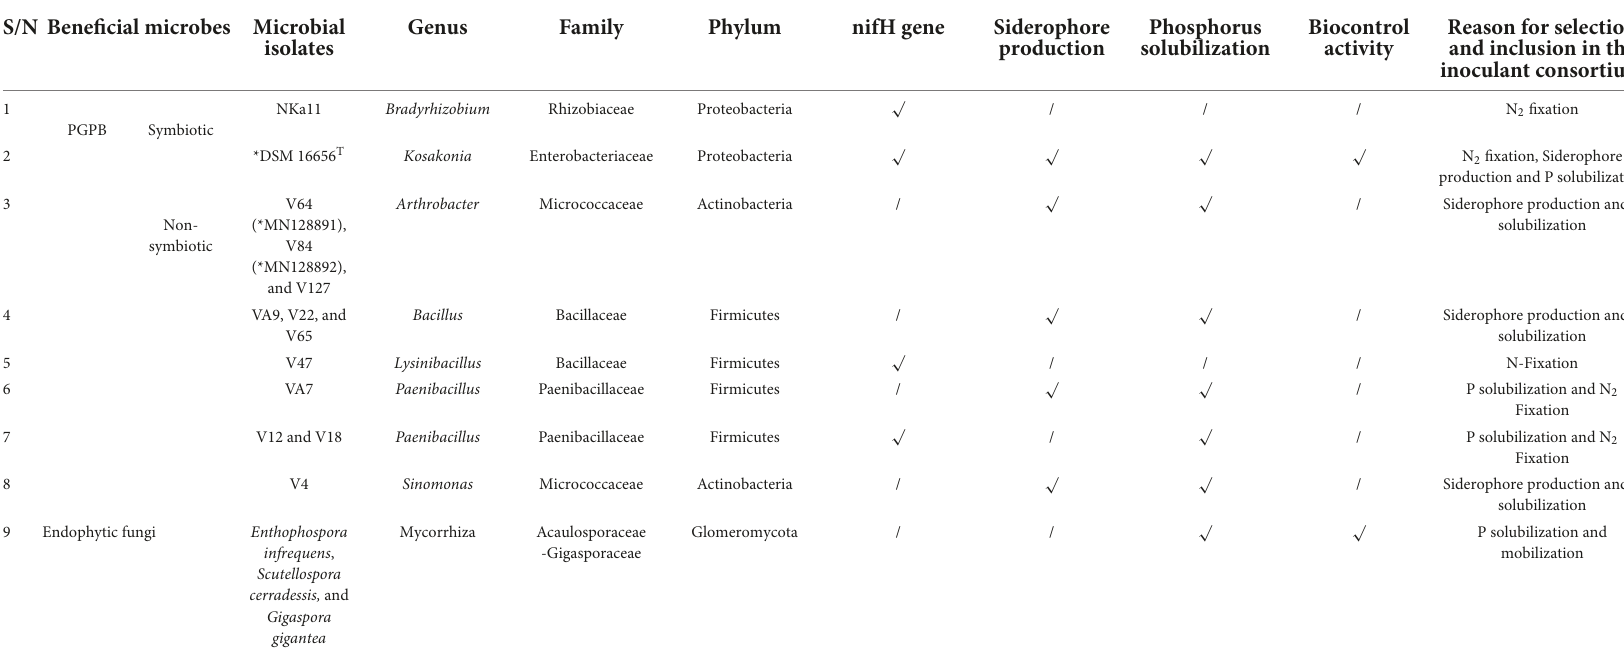
TABLE 1 Plant growth-promoting bacteria (PGPB) and arbuscular mycorrhiza fungi, their functional traits, and potential roles in the consortium of biofertilizers to enhance soil fertility and performance of soybean plants. S/N Beneficial microbes Microbial